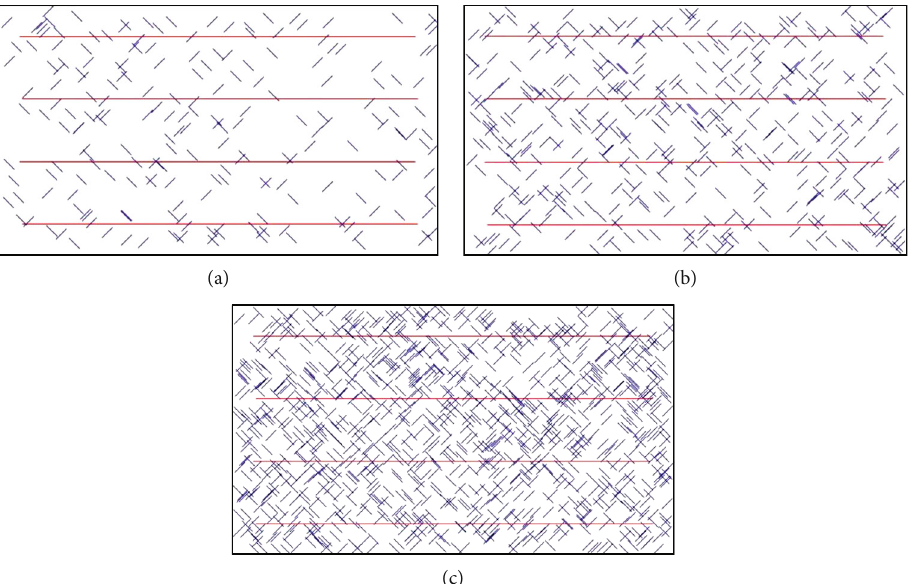
Figure 5: Di ff erent numbers of natural fractures under the constant length considered in the well spacing optimization: (a) minimal number, (b) P50 number, and (c) maximum number.